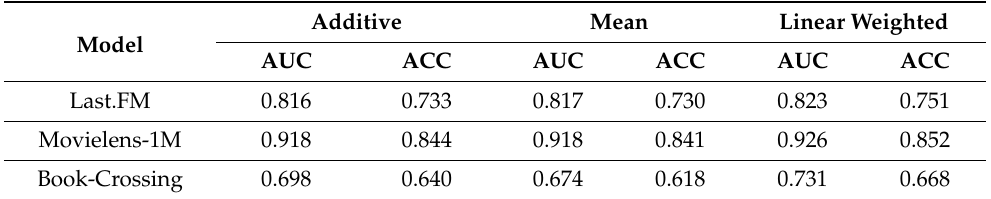
Table 3. Different fusion method results.